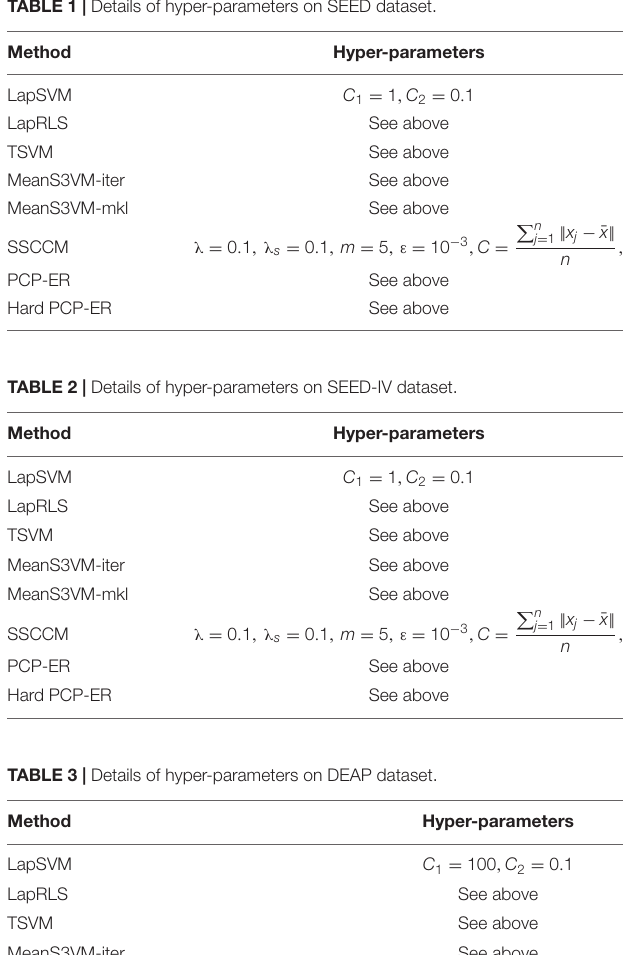
TABLE 1 | Details of hyper-parameters on SEED dataset.